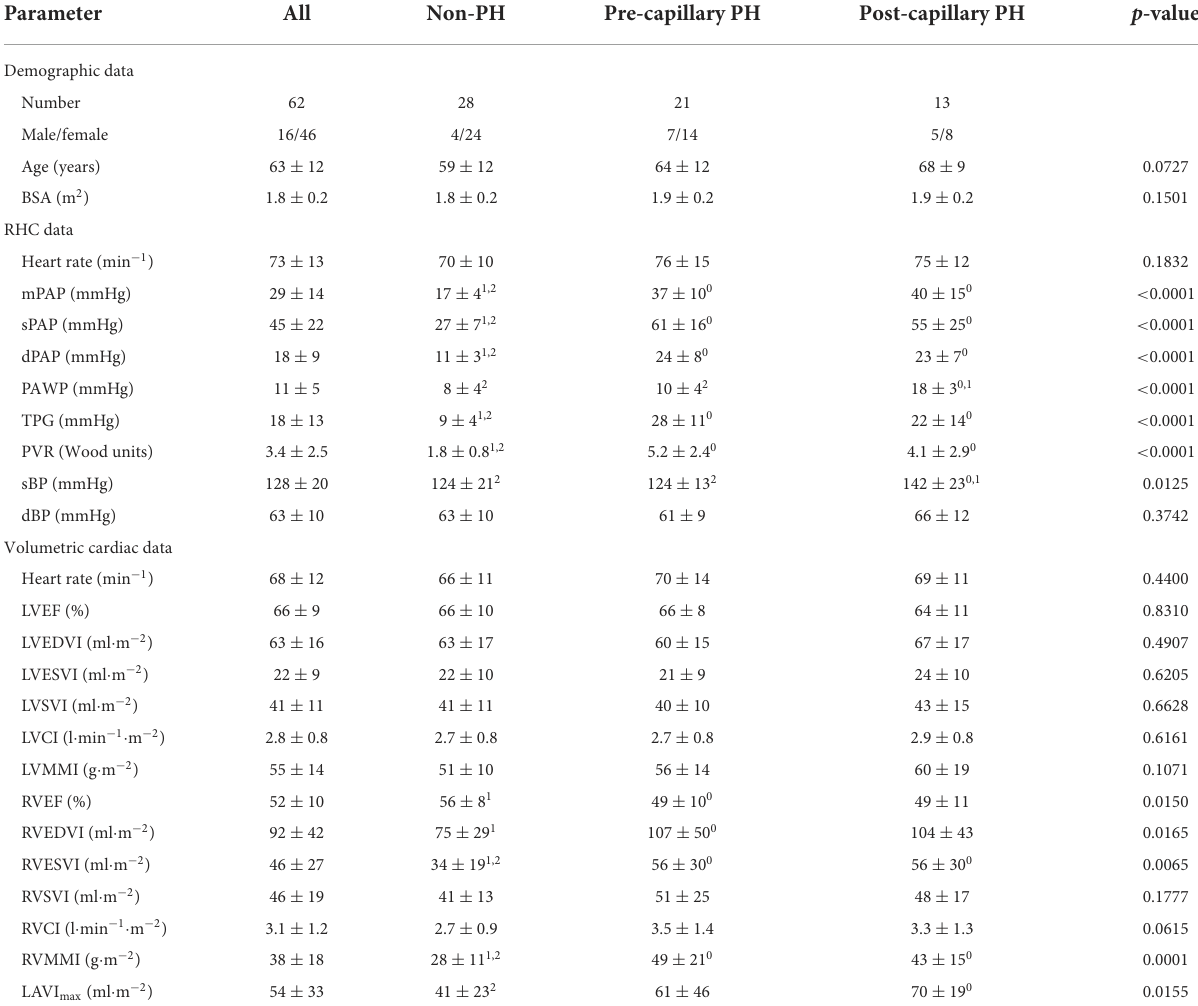
TABLE 1 Demographic, RHC-derived hemodynamic and volumetric cardiac data of the study population. Parameter